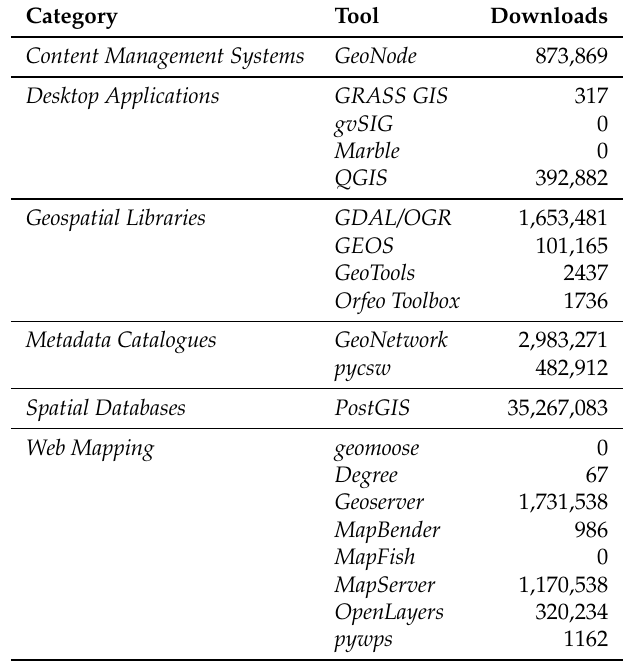
Table 2. Number of downloads for each OSGeo tool in Docker Hub . All results are published in Zenodo